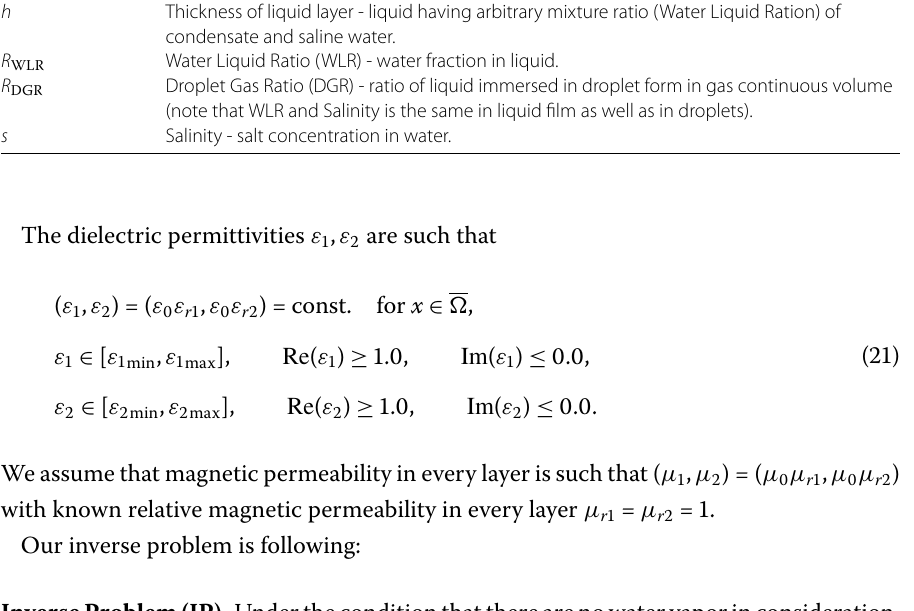
Table 1 Parameters to be determined in IP Parameter